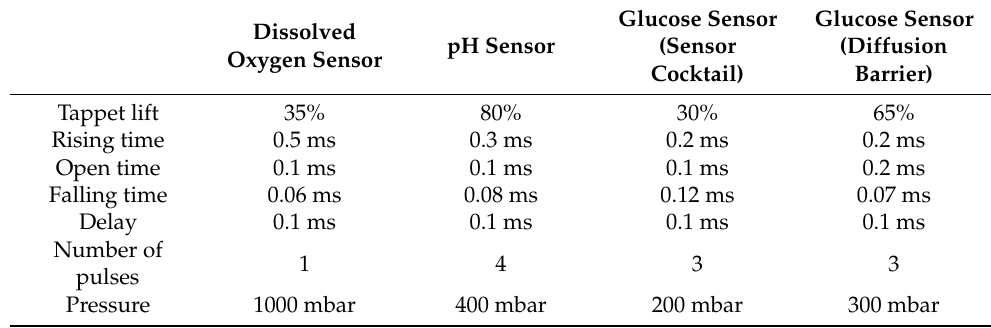
Table A2. Microdispenser settings for the preparation of the dissolved oxygen, pH and glucose